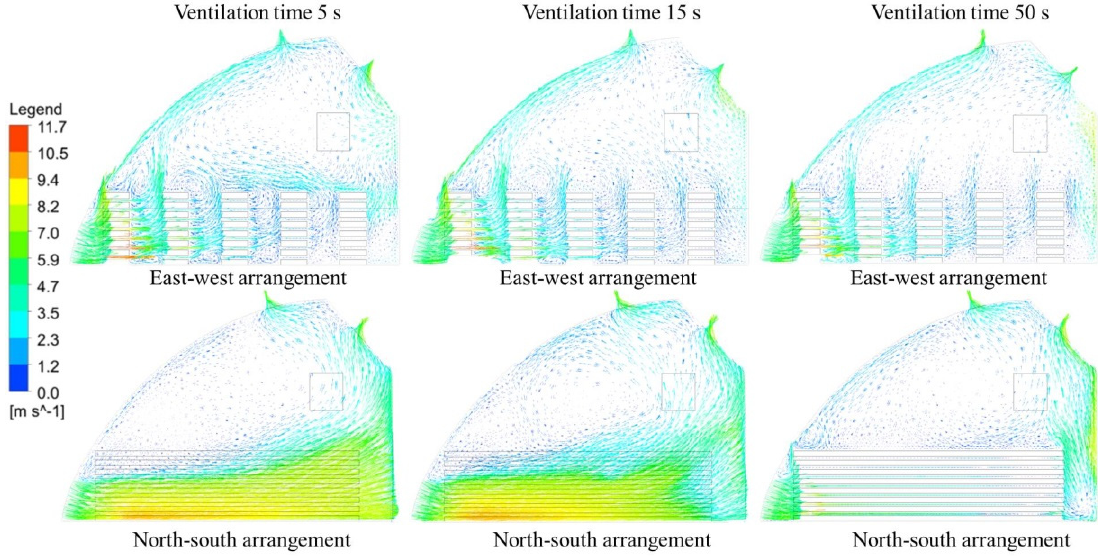
Figure 7. Velocity vectors of typical vertical cross sections under different arrangements of cultiva- tion racks.